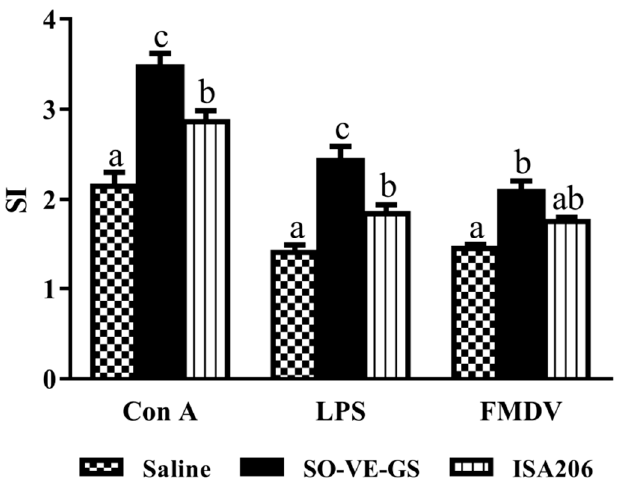
Figure 3. Lymphocyte proliferative responses. Mice ( n = 6 / group) were i.m. immunized twice at a 2-week interval with the FMDV antigen in saline or adjuvanted with SO-VE-GS or ISA206. Splenocytes were isolated from spleens harvested 2 weeks after the boost. The cells were cultured with Con A (5 µ g / mL), LPS (5 µ g / mL), or an inactivated FMDV antigen (10 µ g / mL) for 48 h, respectively. The MTT method was used to measure cell proliferation, which was expressed as a stimulation index (SI). The values are presented as means ± SE. Bars with di ff erent letters are statistically di ff erent ( P < 0.05).